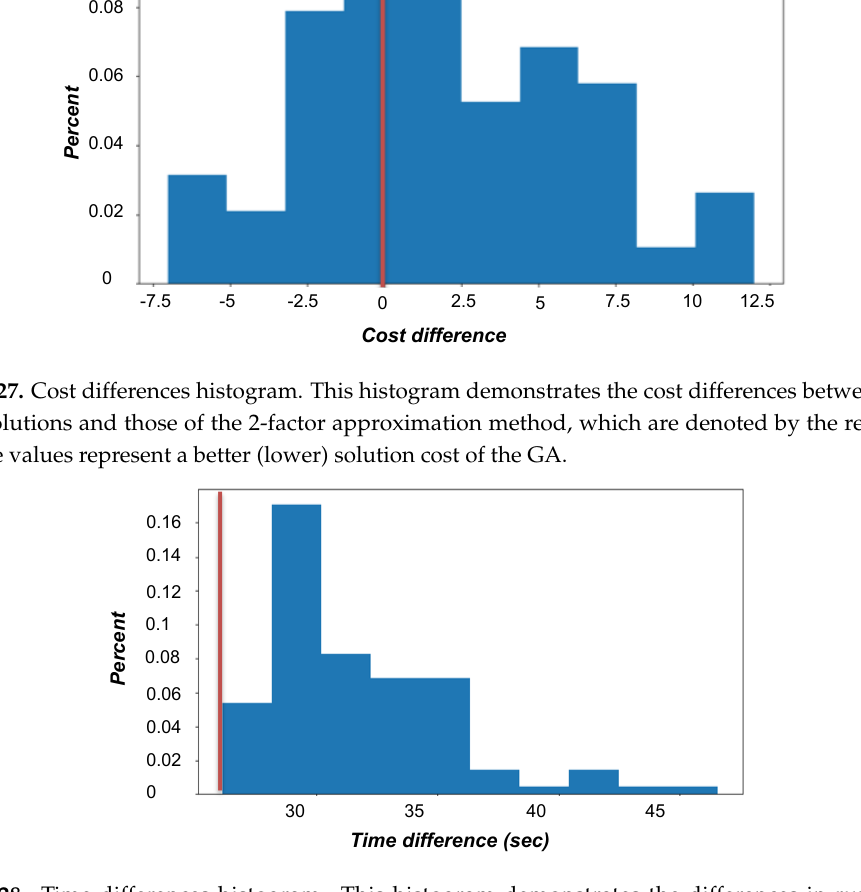
Figure 28. Time differences histogram. This histogram demonstrates the differences in run time between the GA and the 2-factor approximation method, which are denoted by the red line. Positive values represent better (faster) run time of the